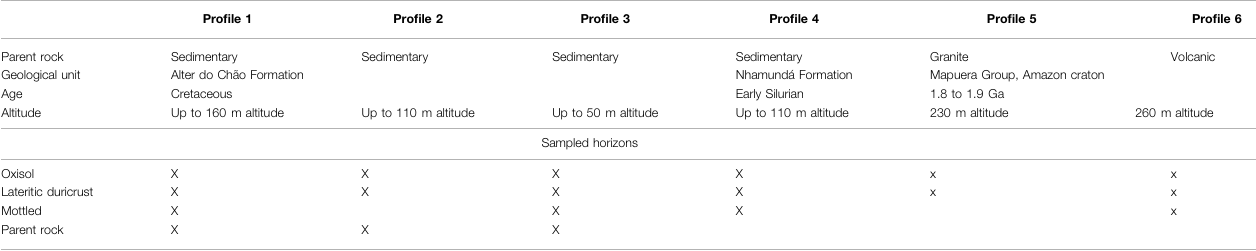
TABLE 1 | Main characteristics of the study pro fi les and